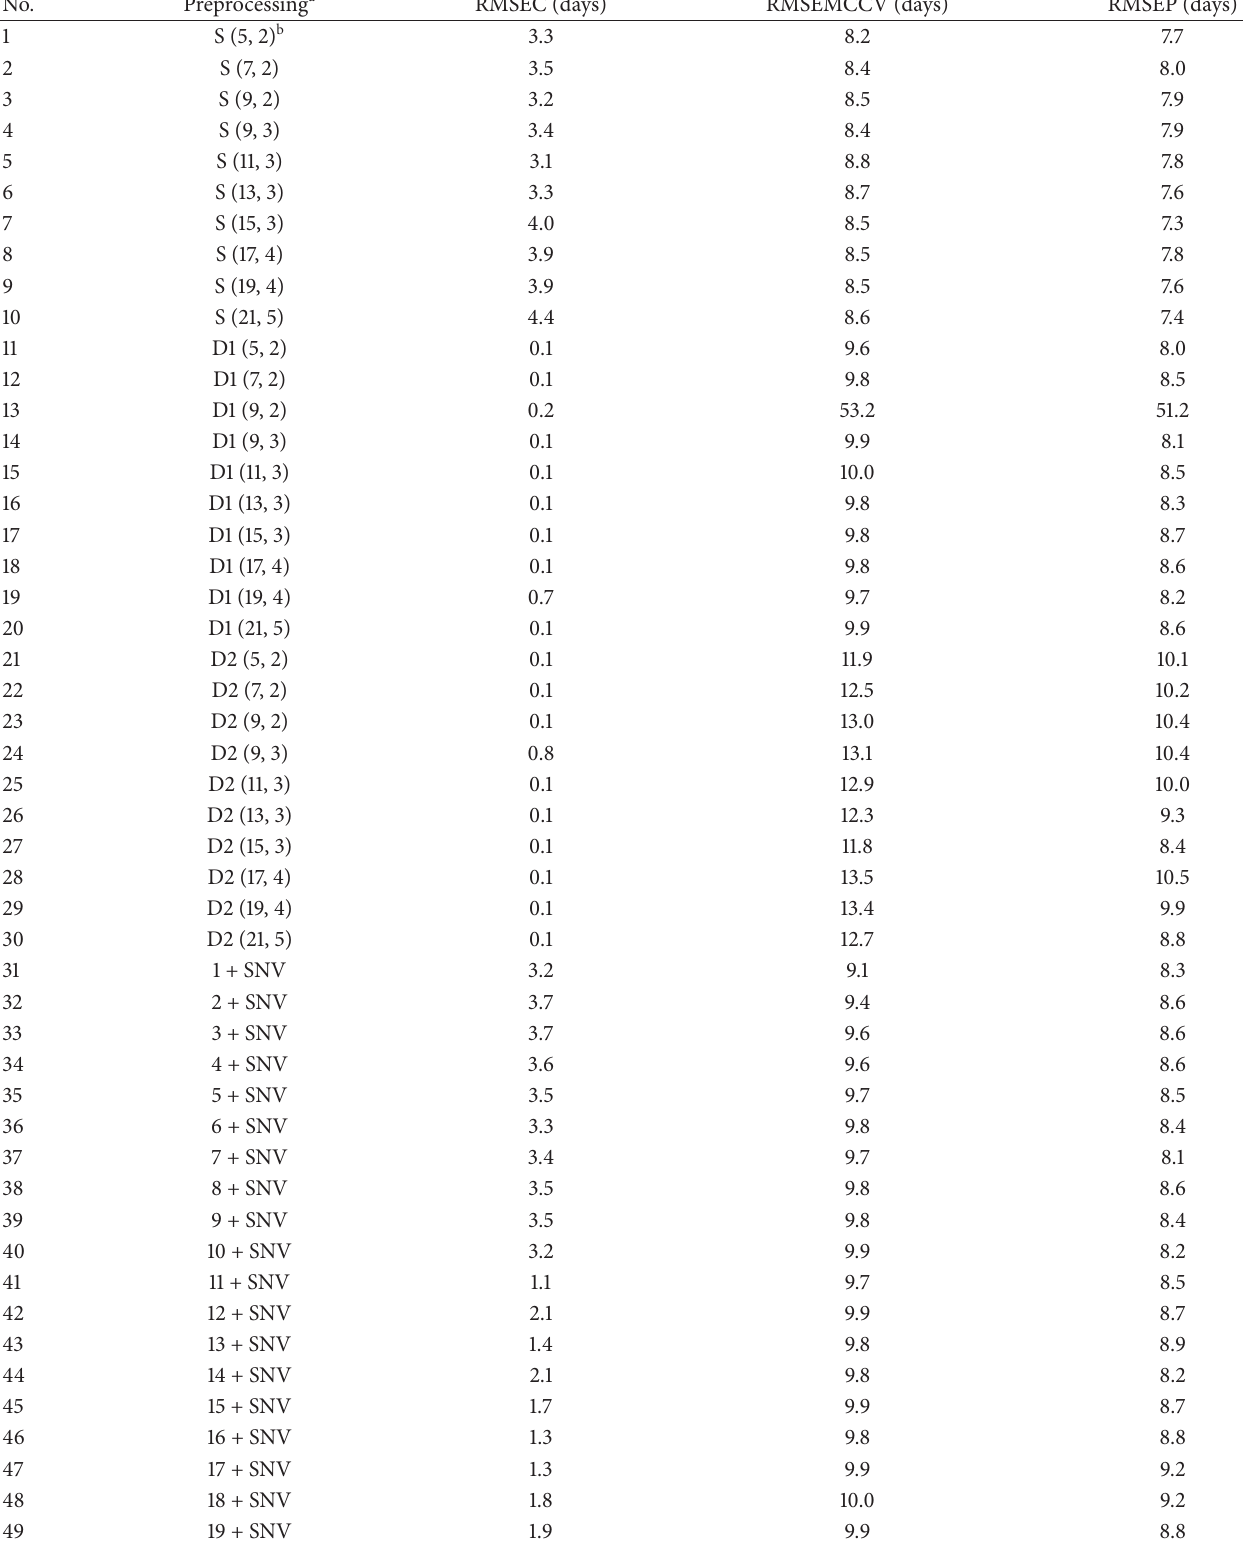
Table 2: Different preprocessing methods used for data fusion and the results of different